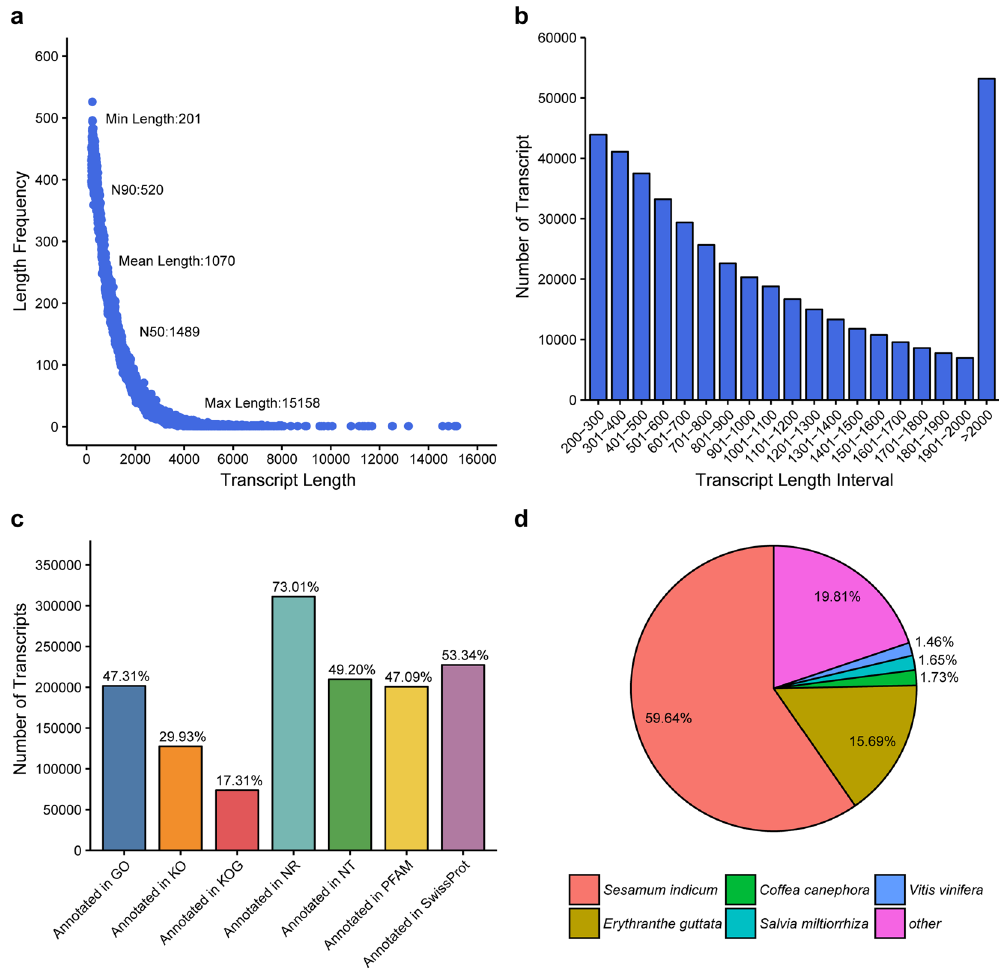
Figure 2. Illumina sequencing and transcriptomes of L. angustifolia . ( a ) Detailed information on the assembled unigenes. ( b ) Size distributions of the unigenes. ( c) Annotation of the unigenes in seven various databases. ( d) Species distribution of the annotated